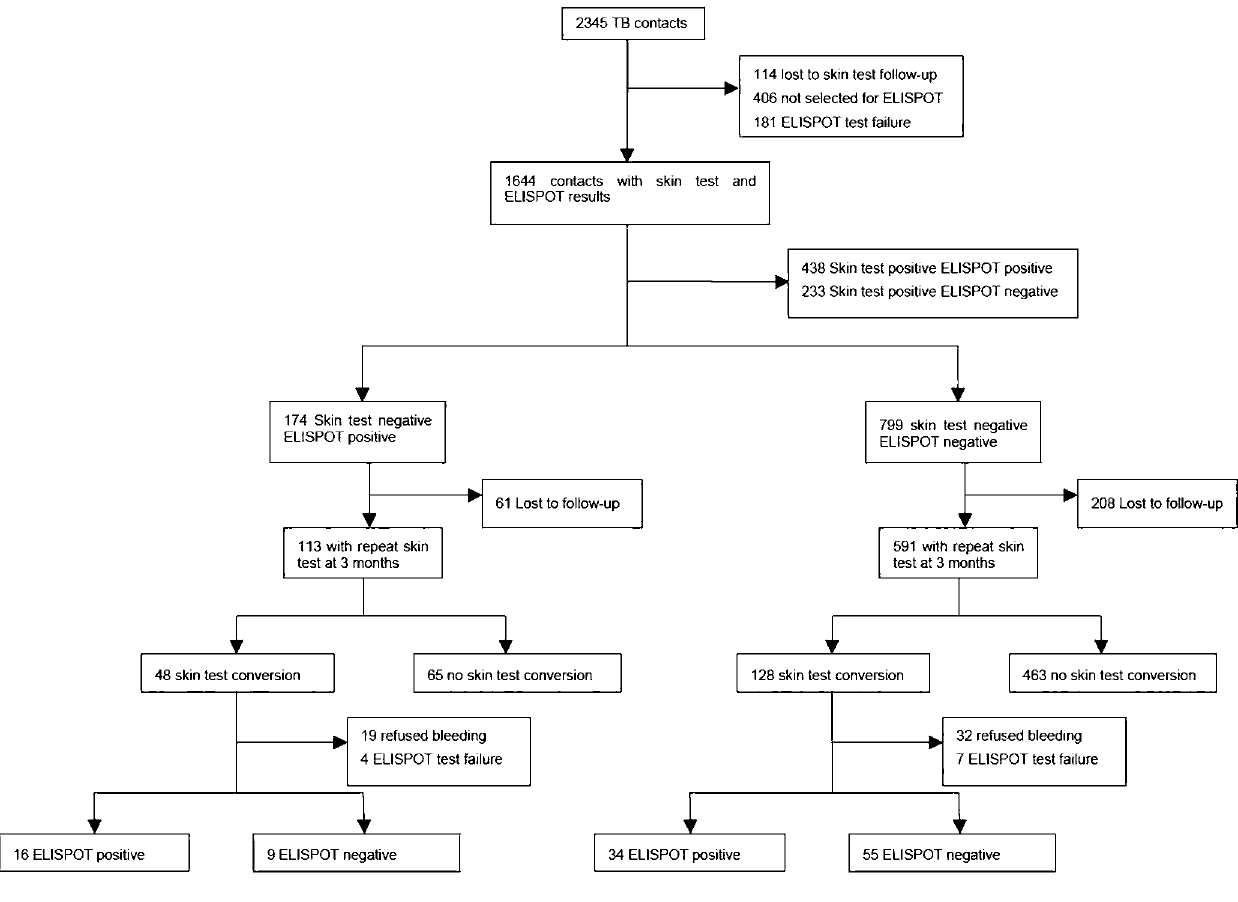
Figure 1. Study profile.